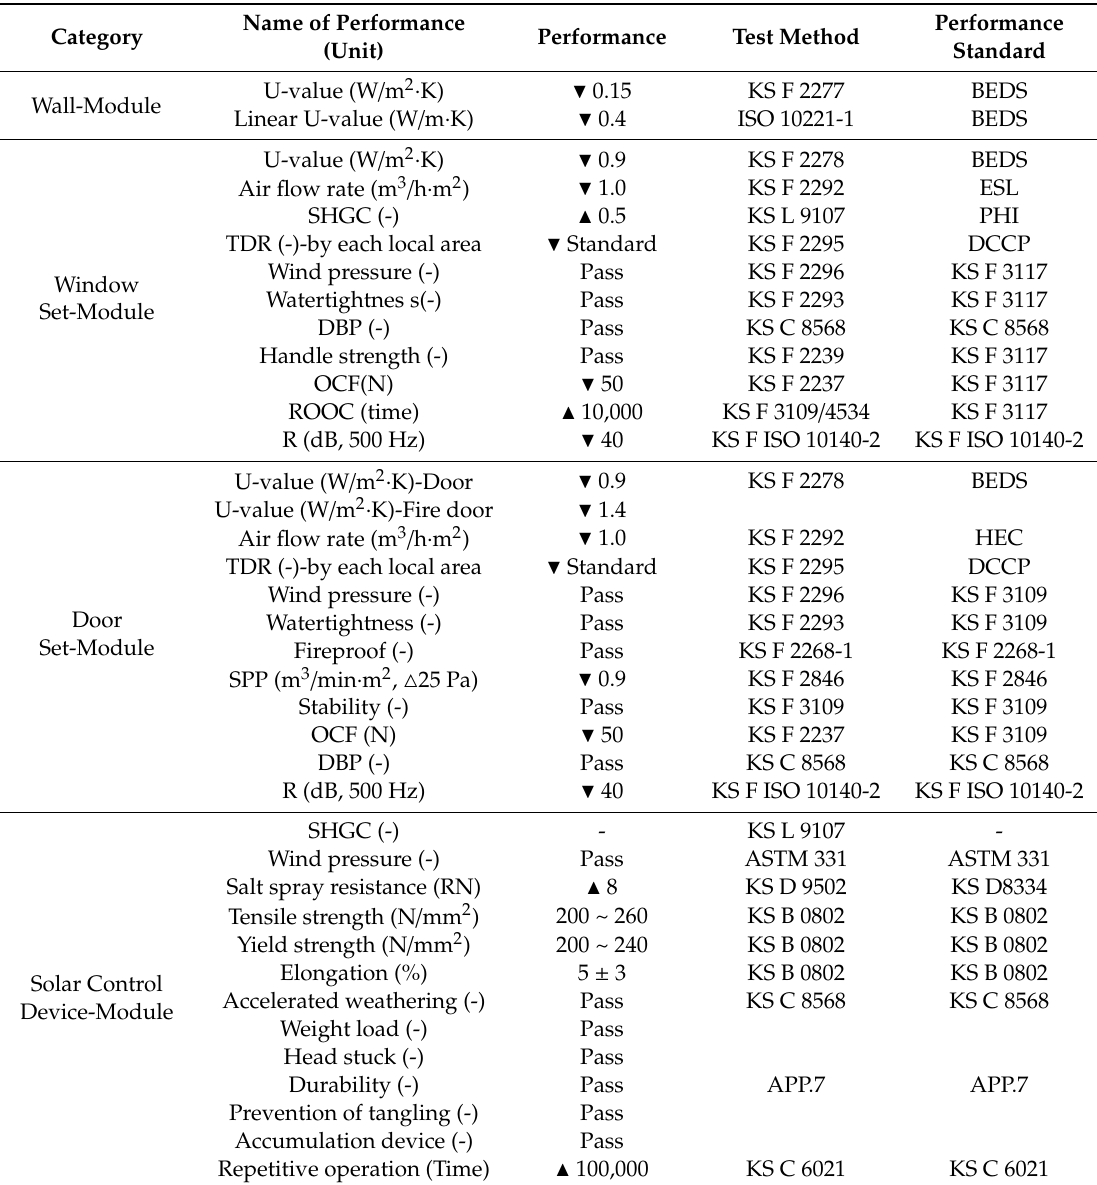
Table 5. Test methods and performance reference of the